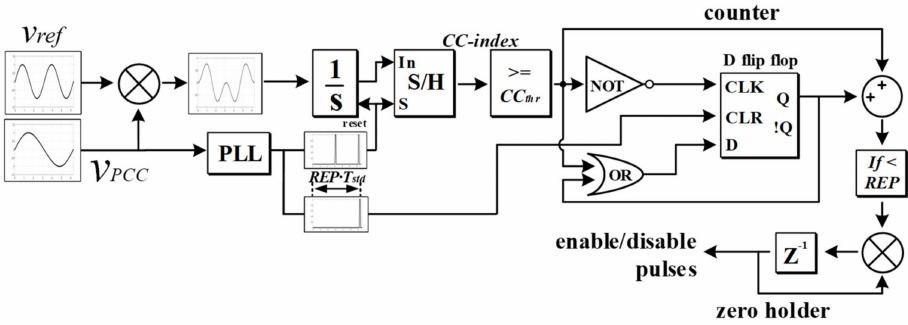
Figure 4. The anti-islanding technique that has been proposed in reference